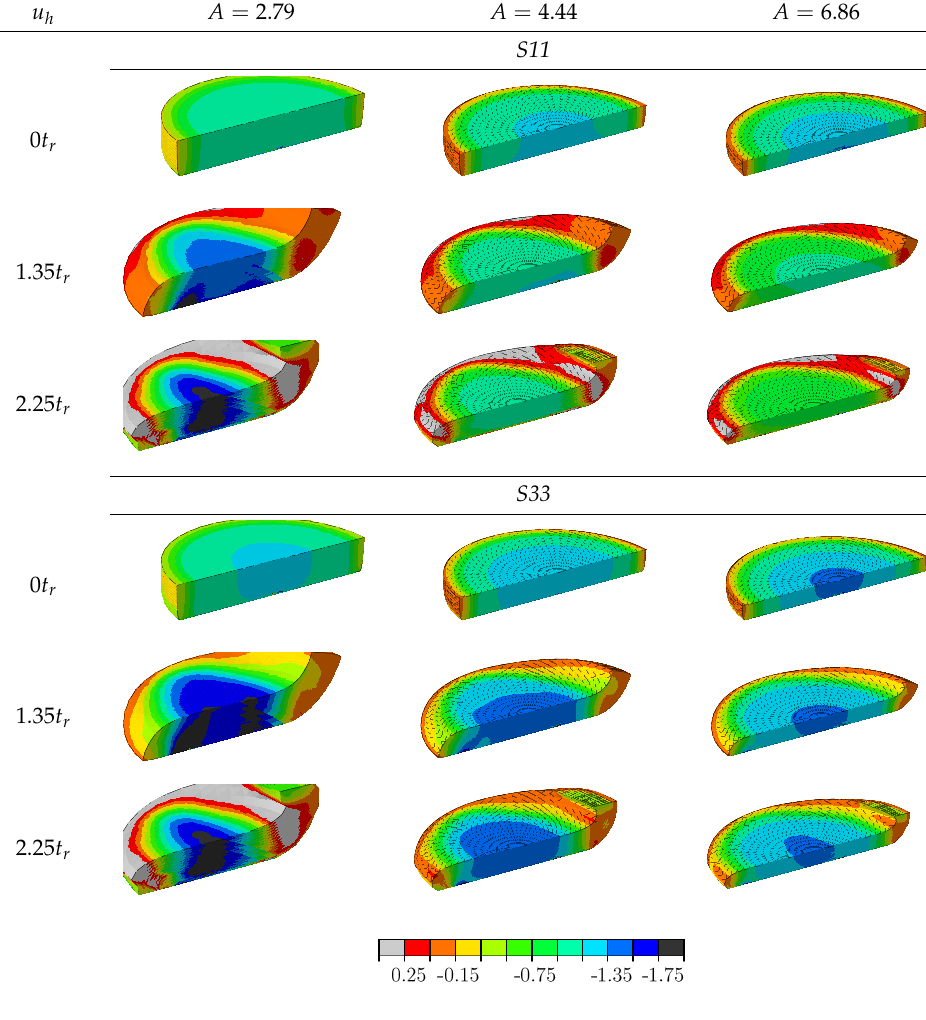
Figure 13. Influence of aspect ratio A on the normal axial S11 and vertical S33 stress